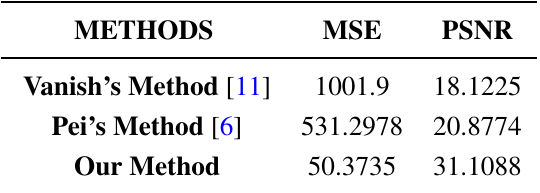
Figure 6. Comparison results of different methods on the CD case behind plants from Stanford. ( a ) Ground Truth; ( b ) Reference camera view; ( c ) Result of Vaish et al. [11]; ( d ) Result of Pei et al. [6]; ( e ) All-in-focus image by our method; ( f ) Comparison results, Column 1 is Vaish’s result, Column 2 is Pei’s result and Column 3 is our method’s result. Table 1. PSNR of CD cases by different